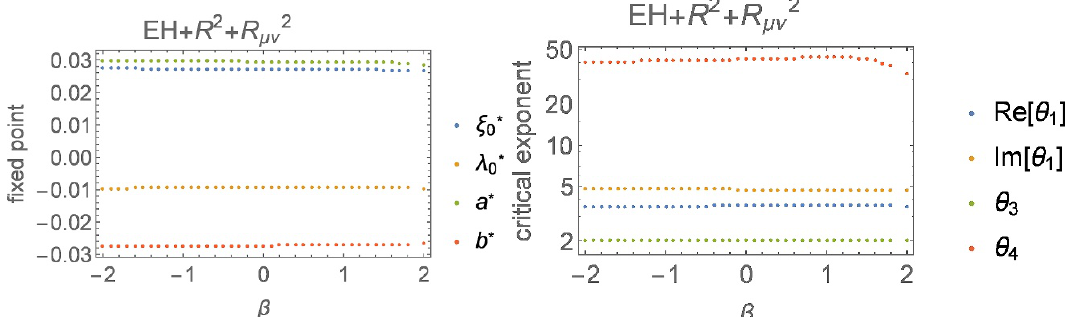
Figure 7 . The dependences of the stable (cid:12)xed point and the stable critical exponent on (cid:12) in the \EH + R 2 + R 2 " truncation. (cid:22)(cid:23)